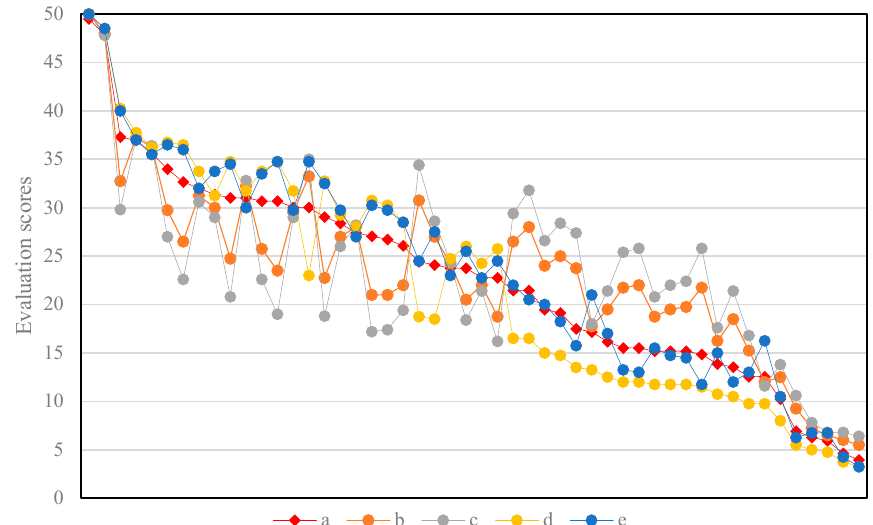
Figure 9. The evaluation scores of different weight assignment schemes.